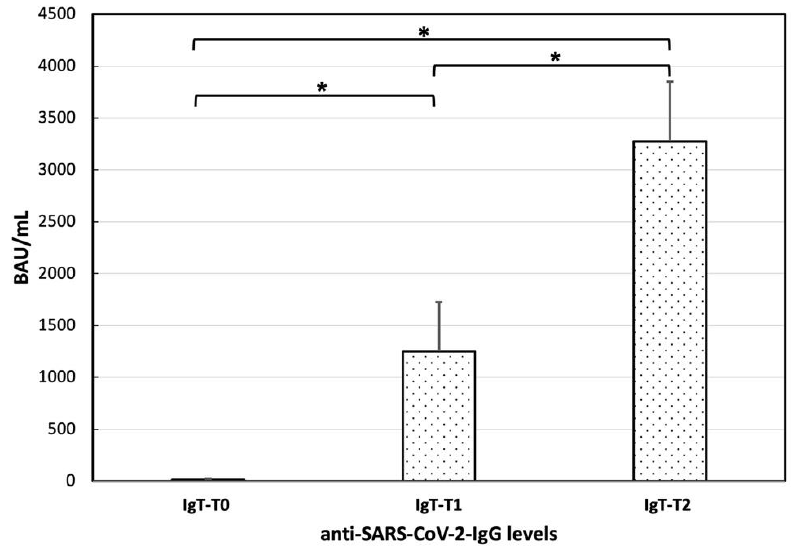
Figure 1. Anti-SARS-CoV-2-IgG levels at T0, T1, and T2 in our systemic erythematous lupus patients ( n = 41). ANOVA conducted on anti-SARS-CoV-2-IgG levels revealed a significant difference (*) among the determinations at T0, T1, and T2 [F(2,80) = 17.65; p < 0.001]. Post-hoc comparisons revealed significantly higher levels of anti-SARS-CoV-2-IgG levels at T1 (post-hoc p < 0.05) and T2 (post-hoc p < 0.001) compared to T0, and at T2 and compared to T1 (post-hoc p < 0.05). All the controls with C1-INH-HAE demonstrated a positive serological response after a single dose of the vaccine (T1), which significantly increased after the second dose (T2). Specifically, mean anti-SARS-CoV-2-IgG levels were 2.25 ± 4.26 at T0, 895.76 ±